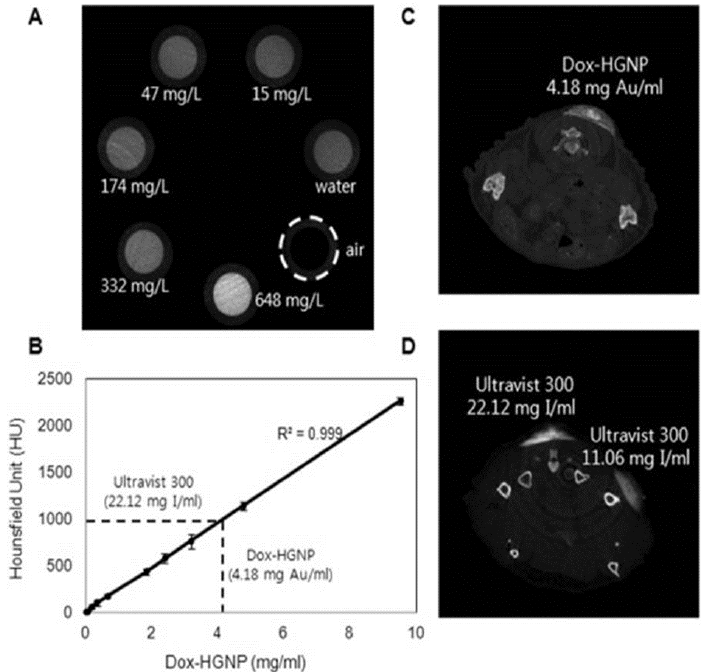
Figure 2. In vitro and in vivo micro-CT images: ( A ) concentration-dependent CT images of air, distilled water, and doxorubicin-loaded hollow gold nanoparticles (Dox-HGNPs); ( B ) X-ray absorption of Dox-HGNP and Ultravist 300; ( C ) cross-sectional CT image in the back skin of mice after injection of Dox-HGNPs; and ( D ) Ultravist 300. Reproduced with permission from [51]. Copyright Journal of Controlled Release, Elsevier, 2015.